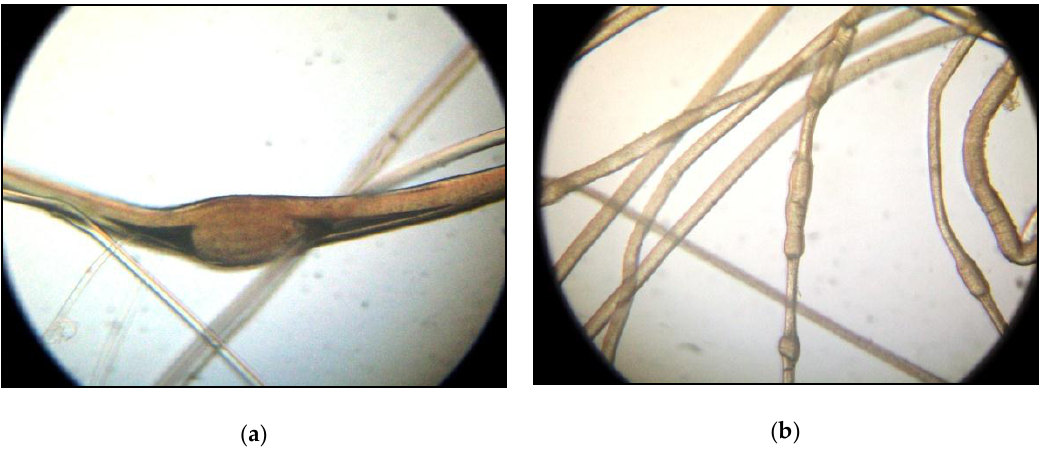
Figure 3. Image of the polyester fibers damages after digging (increase 200 × ): ( a ) local thickening with cavities; ( b ) swelling.